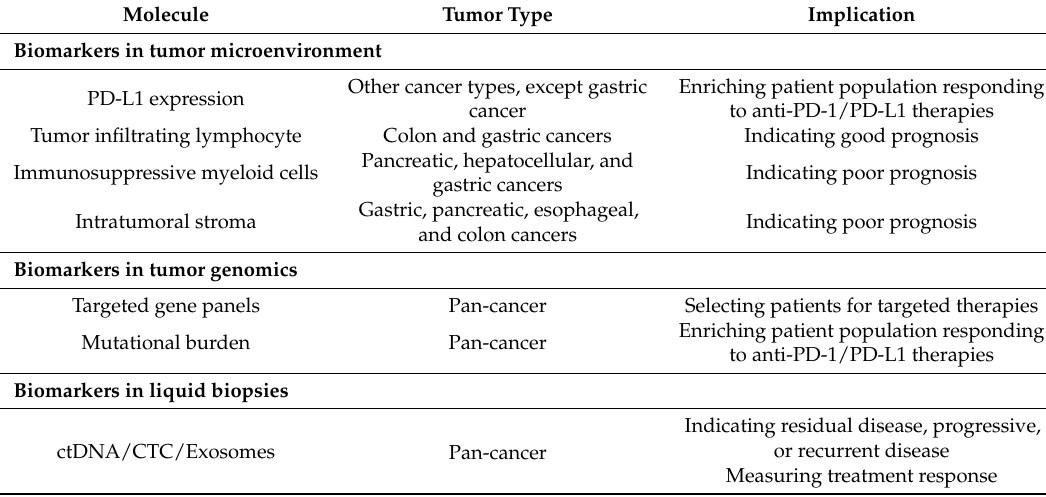
Table 3. New development of